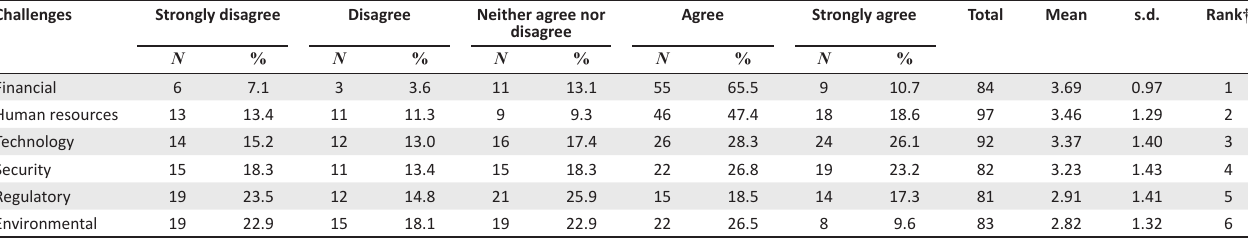
TABLE 7: Respondents’ rating of challenges facing small and medium-sized enterprises. Challenges